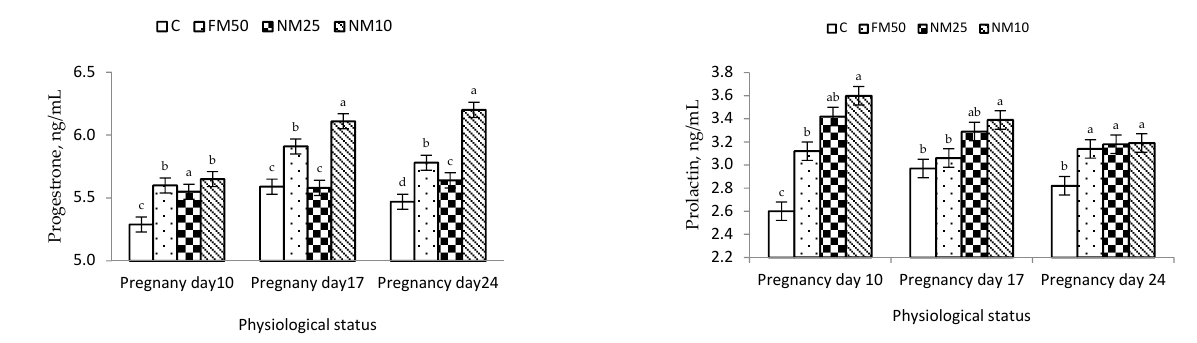
Figure 3. Changes (means ± SEM) in the blood plasma progesterone and prolactin of rabbit does during pregnancy. C = 0 mg/kg BW MLEE, FM 50 = 50 mg/kg BW MLEE, NM 25 = 25 mg/kg BW nanoencapsulated MLEE and NM 10 = 10 mg/kg BW nanoencapsulated MLEE. Means within the same physiological status having different superscripts (a, b, c, d) differ significantly ( p < 0.05). Table 7. Effect of the nanoencapsulated Moringa leaf ethanolic extract (MLEE) on the reproductive performance of female rabbits during the experimental period (Mean ±